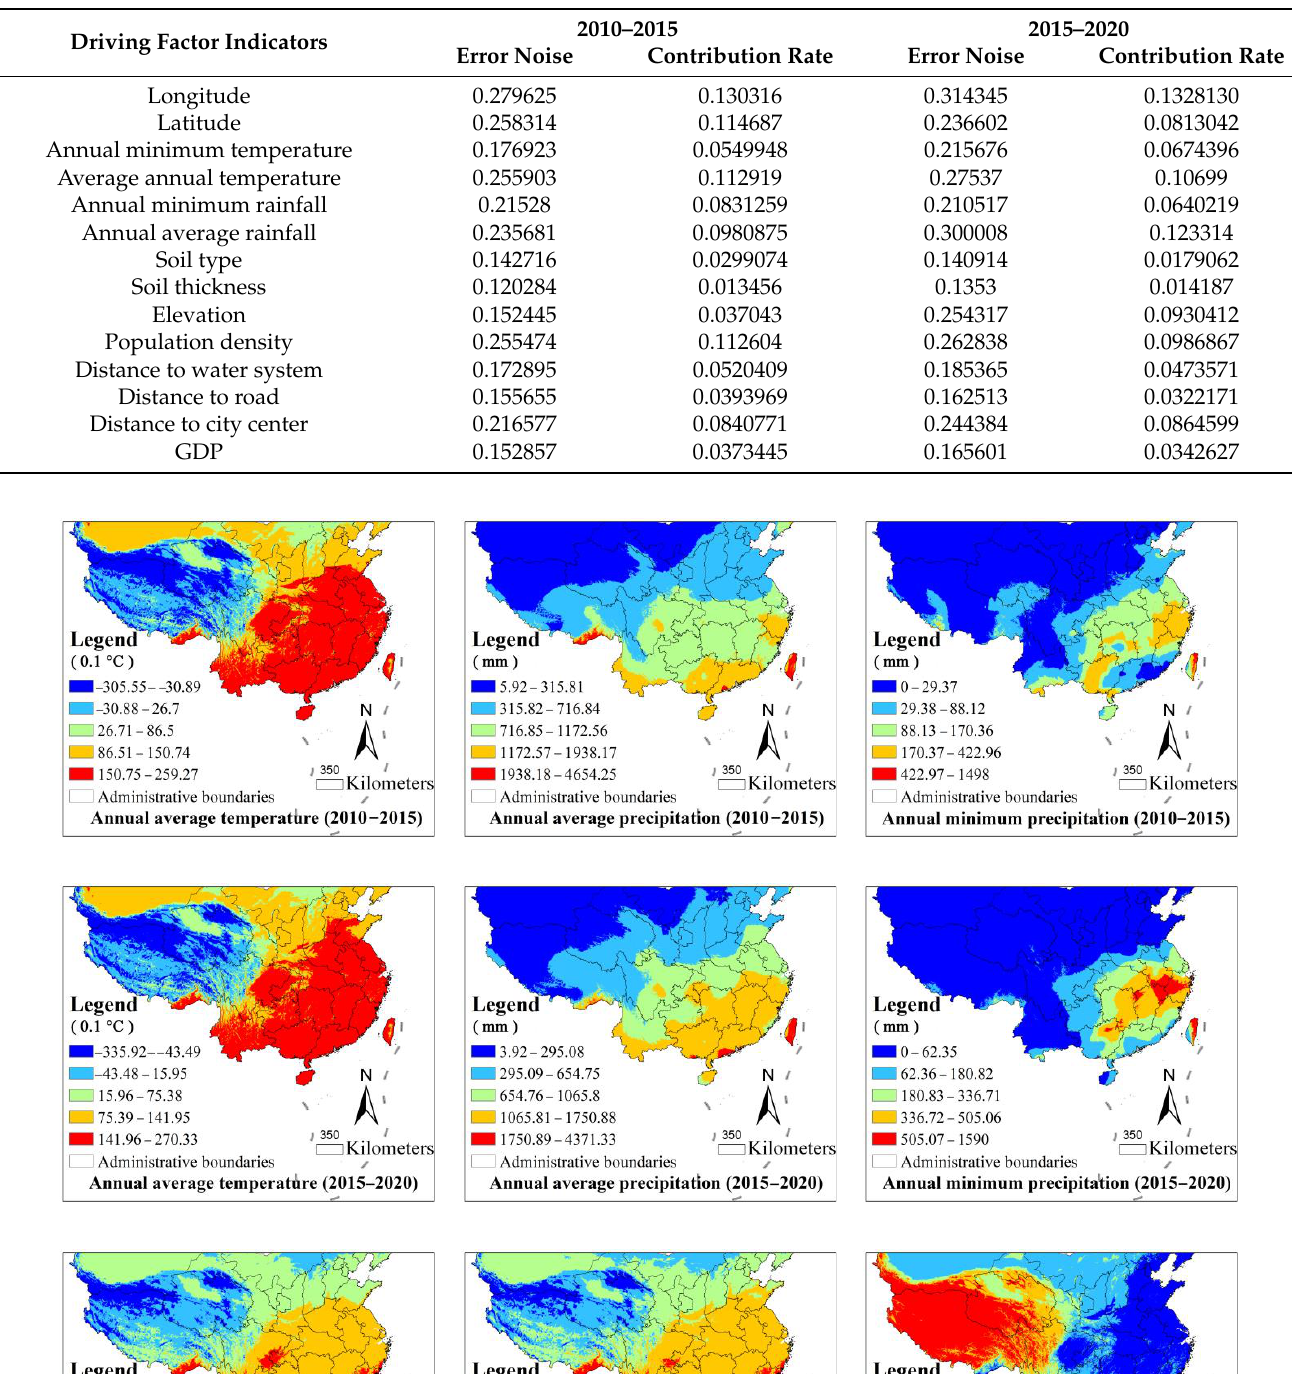
Table 5. Table of the contribution indicators of the drivers of the evolution of the landscape pattern of moso bamboo forest.